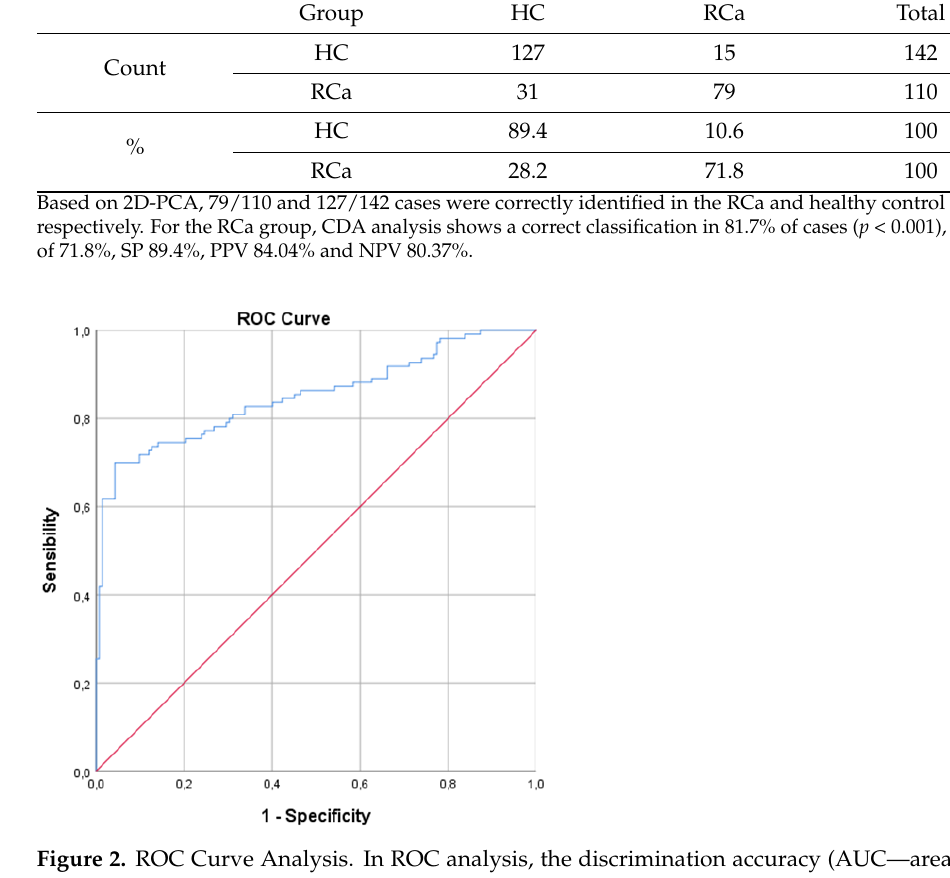
Figure 3. Graphical Abstract of the study. We reported a brief outline of the study, which mainly consists of three phases: collection of urine samples, processing with e-Nose and data analysis.